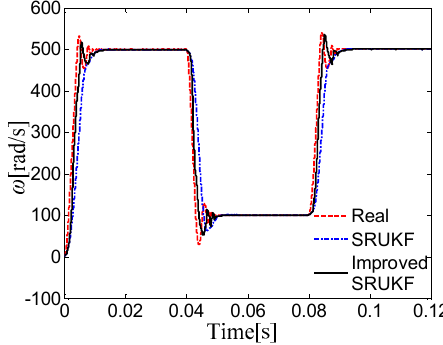
Figure 8. Speed estimation at speed step response.